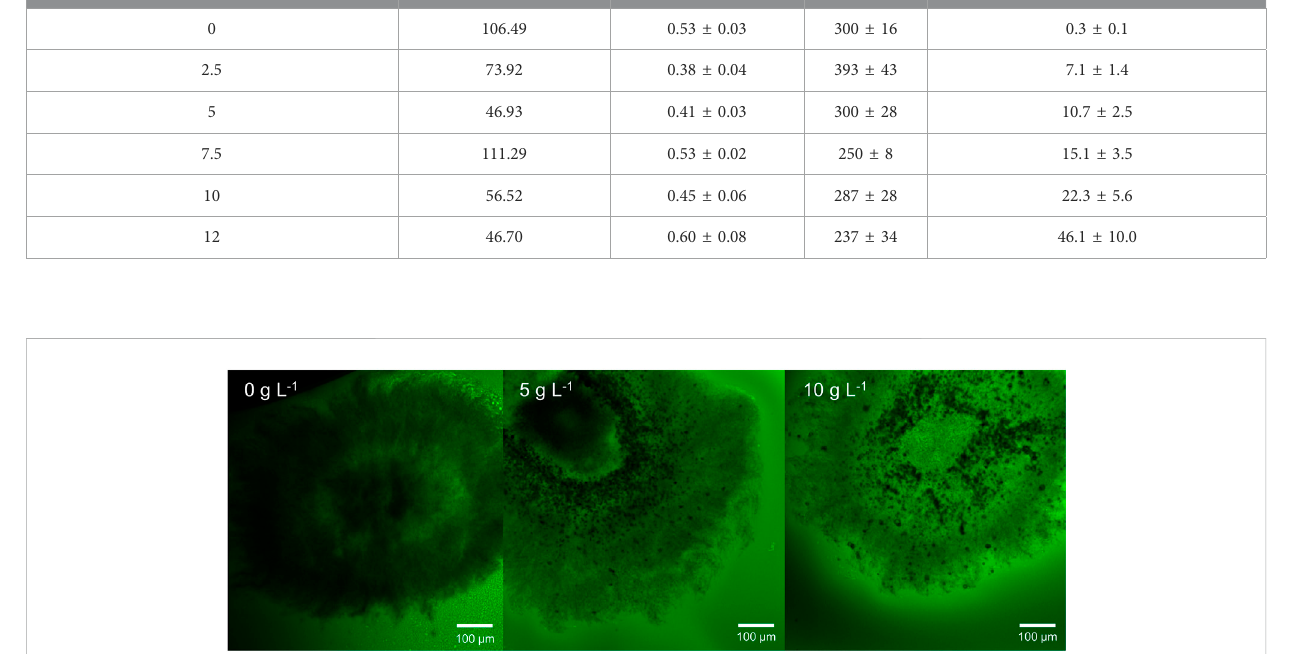
TABLE 1 Overview of the pellet density, the maximum oxygen gradient ( dSatO 2 dr ) max , the active oxygen supplied pellet layer ( Δ r activ ), and the rebeccamycin concentration after 10 days of cultivation corresponding to the glass microparticle concentration of the culture. Glass microparticle concentration (g L − 1 )